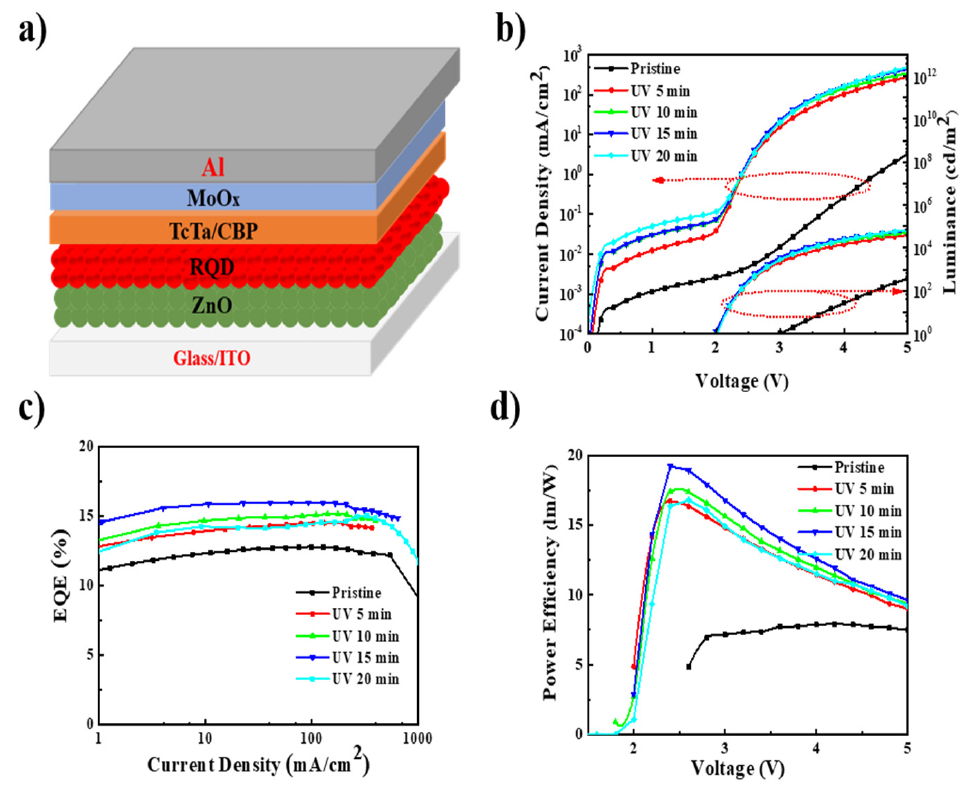
Figure 1. ( a ) Schematic structure of inverted QLEDs; ( b ) the current density–voltage–luminance (J–V–L) characteristics; ( c ) external quantum efficiency–current density (EQE–J) characteristics; ( d ) and power efficiency–voltage (PE–V) characteristics of the QLEDs treated with UV irradiation for different durations. Table 1. The characteristics of the QLEDs with different UV irradiation times.